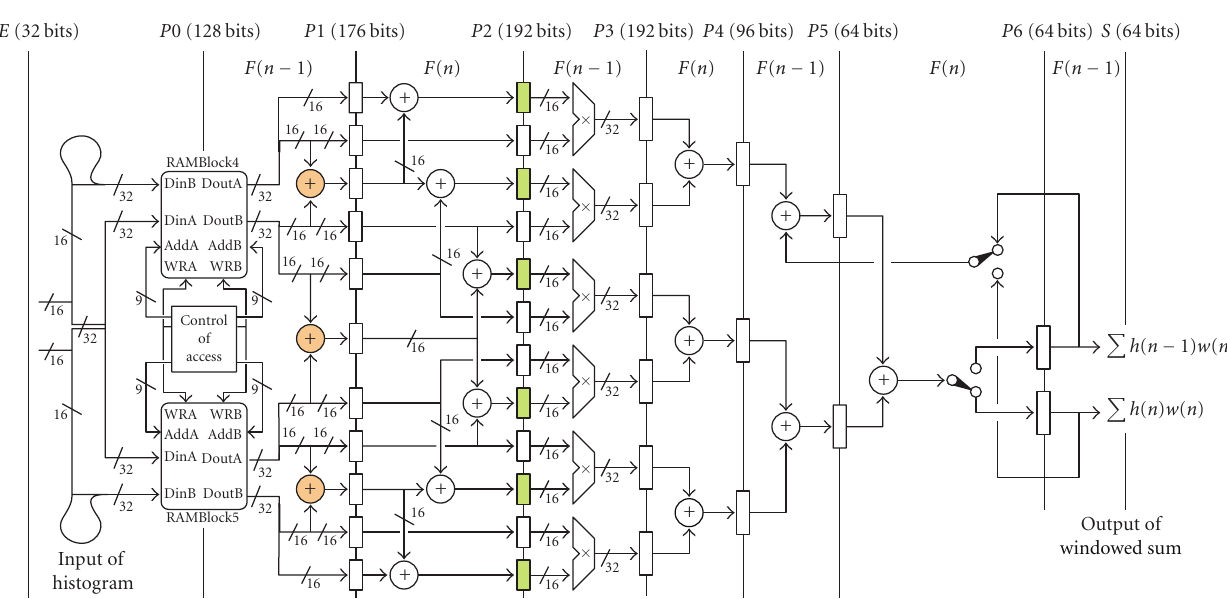
Figure 5: Circuit for calculating the windowed correlation (includes windowed calculation